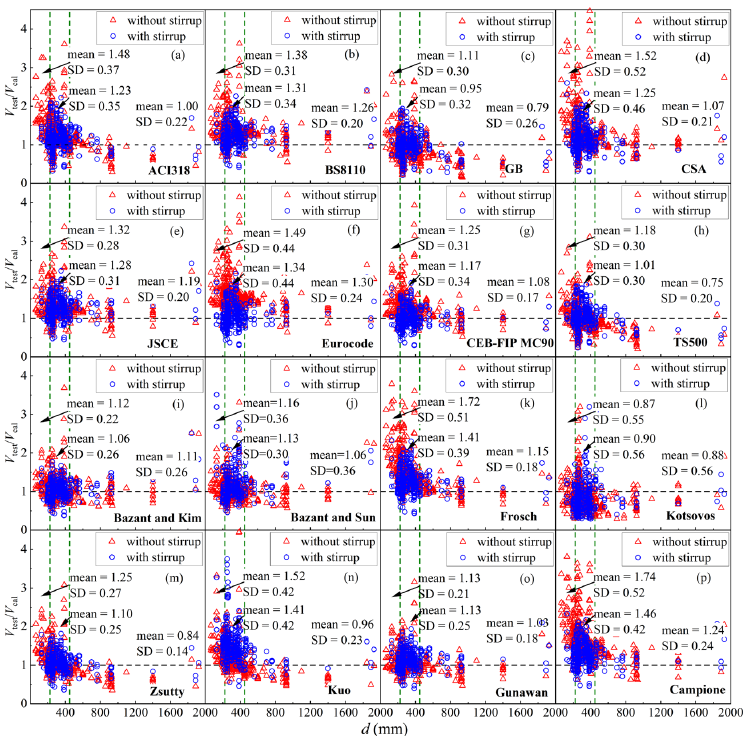
Figure 9. The relationship between the ratios ( V test / V ca l ) and effective depth of ( a ) ACI318; ( b ) BS8110; ( c ) GB; ( d ) CSA; ( e ) JSCE; ( f ) Eurocode; ( g ) CEB FIP MC-90; ( h ) TS500; ( i ) Bazant–Kim; ( j ) Bazant–Sun; ( k ) Frosch; ( l ) Kotsovos; ( m ) Zsutty; ( n ) Kuo; ( o ) Gunawan; ( p ) Campione.